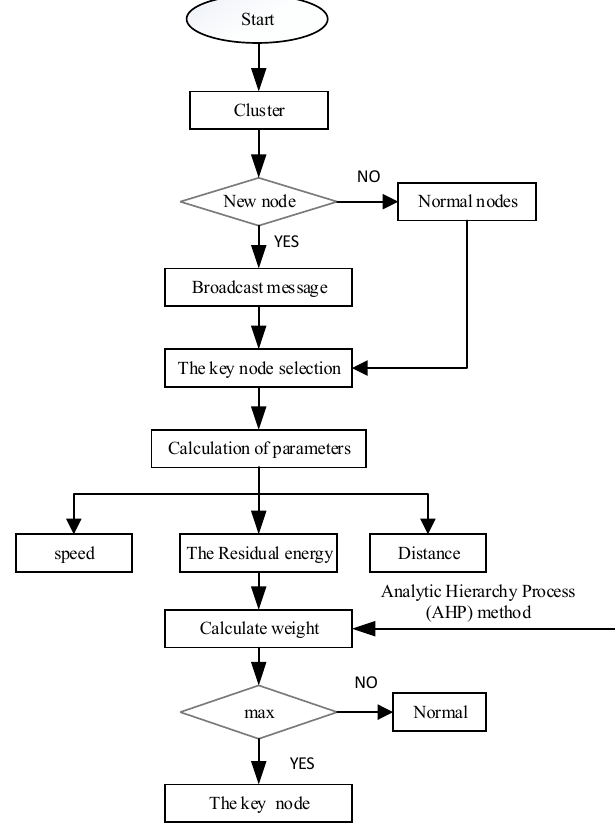
Figure 3. Flow chart for selecting the key node. Table 3. Paired comparison matrix.